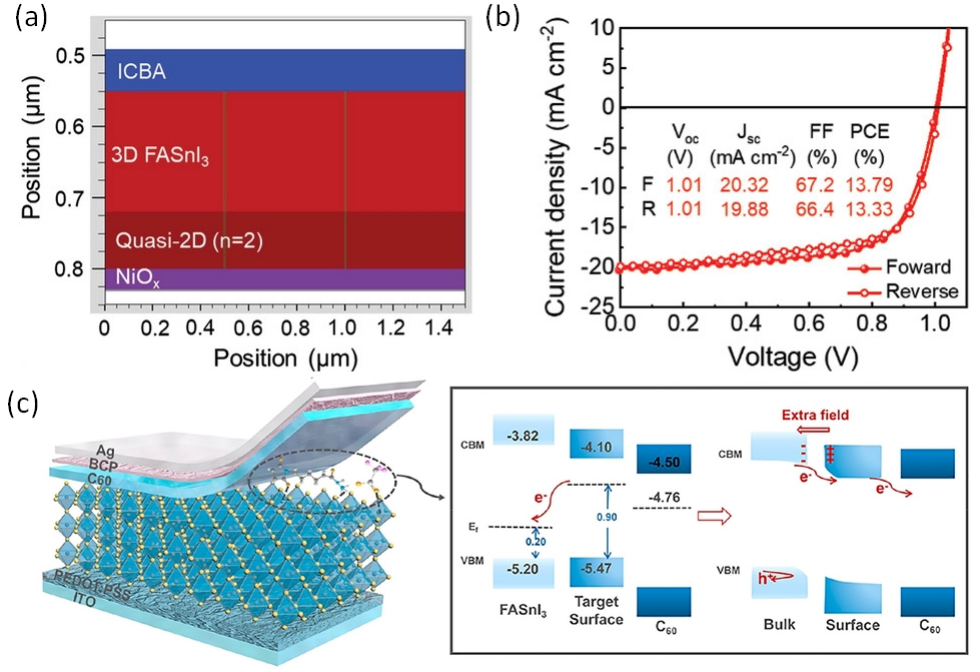
Figure 16. ( a ) The schematic diagram of fabricated 2D/3D Sn-PVK shows that the more soluble 2D phase was settled at the bottom of perovskite/top of NiO x under the effect of vacuum, ( b ) Obtained best J-V characteristics show 1.01 V Voc irrespective of scan direction. Reproduced from [55] under Creative Commons CC BY 4.0. ( c ) Passivation of the Sn-PVK surface with 6-maleimidohexanehydrazide trifluoroacetate leads to better banding and charge extraction at C60/Sn-PVK interface. The properties of the Sn-PVK surface were changed to n-type. Reproduced with permission [83]. Copyright, 2022, American Chemical Society.